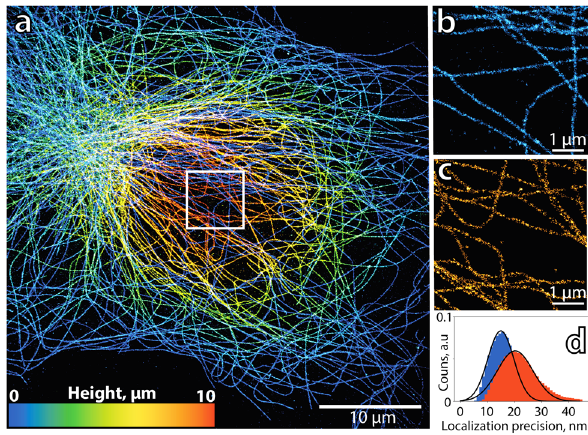
Figure 3: Multiplane single-molecule localization microscopy. (a) A height coded render of 20 resolved planes spaced 500 nm apart. The same dataset as in Figure 2 was processed. (b – c) Zoom- ins from the bottom (b) and top (c) planes. (d) Localization precision histogram showing a localization precision difference of 5.3 nm in the 10 µm axial